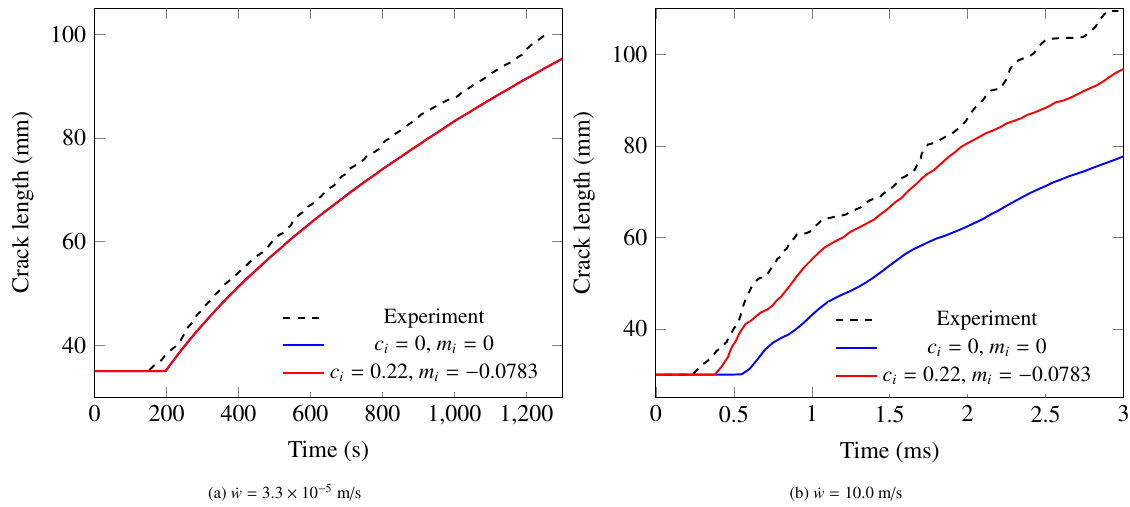
Figure 23. A comparison between experimental and cohesive zone modeling results for the test rate of ( a ) ˙ w = 3.3 × 10 − 5 Figure 23: Comparison between experimental and cohesive zone modeling result for test rate of (a) ˙ w = 3 . 3 m/s; ( b ) ˙ w = 10.0 m/s The numerical models were used to simulate a series of DCB tests of a unidirectional PEEK / carbon composite lam- 422 inate with di ff erent test rates from 3 . 3 c i = m i = 0) and rate-dependent cohesive law were considered for each analysis. It can be seen from Fig. 23(a) that 424 the rate-independent model and rate-dependent model produce almost the same time vs. crack length curve for the 425 lowest loading rate. They both match reasonably well with the measured curve. For the test rate of 10.0 m / s (Fig. 426 23(b)), the time vs. crack length curve obtained with the rate-dependent model still matches reasonably well with the 427 measurement in terms of crack speed, while the rate-independent model significantly underpredicts the crack speed. 428 It is noted that the influence of the properties of matrix and fiber / matrix interface is considered by the values of the 429 rate-dependent parameters in Eqs. (2), (3) and (4). 430